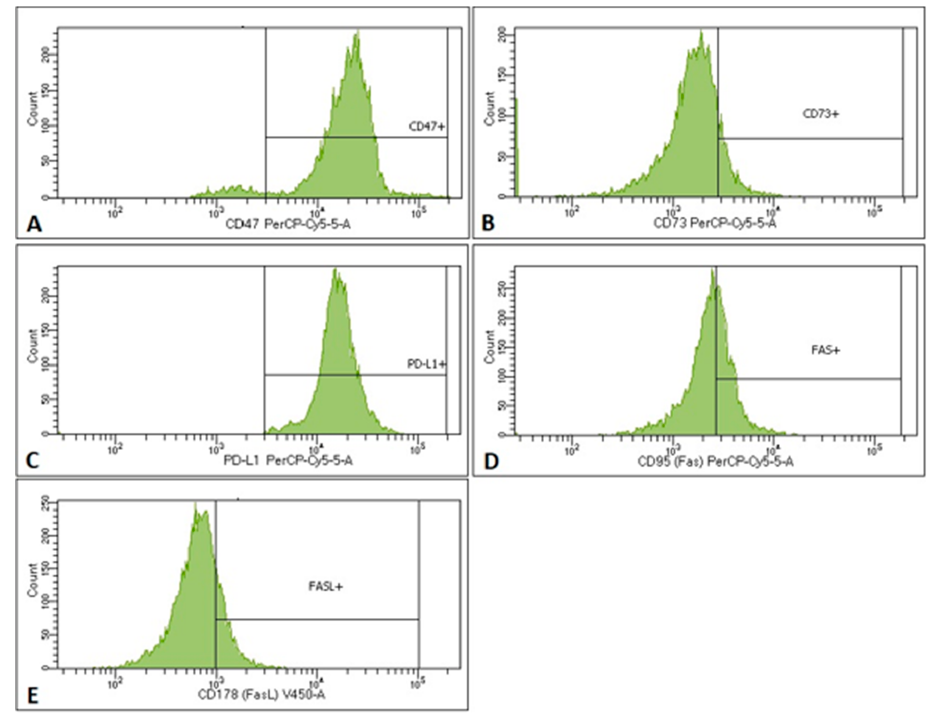
Figure A1. ( A – E ) Representative histograms used to assess the presence of immunomodulatory Figure A1. A-E ) Representative histograms used to assess the presence of immunomodulatory Cancers 2020 , 12 , x FOR PEER REVIEW molecules on CSCs. molecules on CSCs.